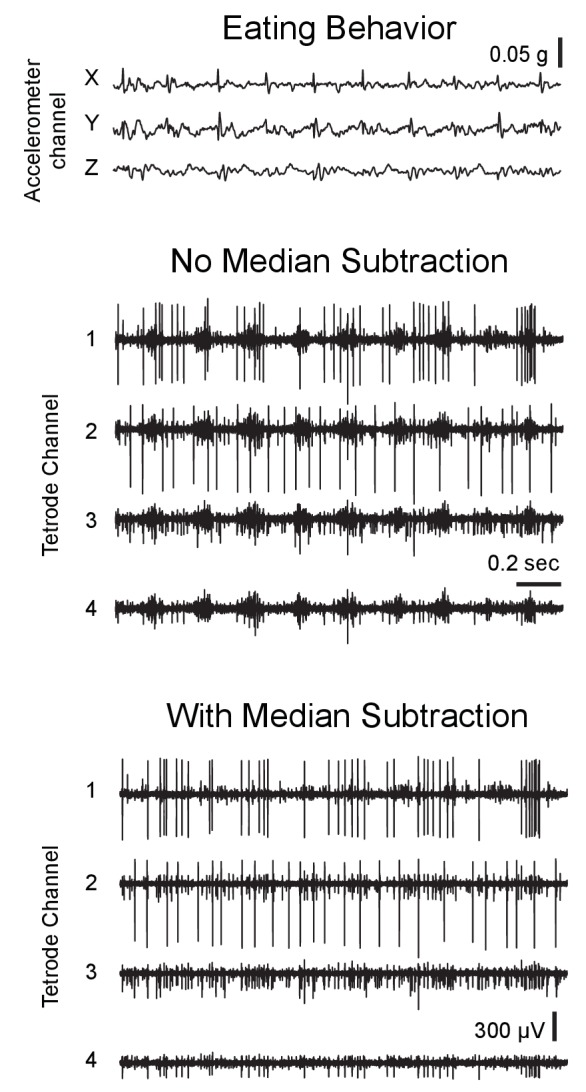
Effect of median subtraction on recording noise in behaving rats.2 s segment of an example 3-axis accelerometer trace (top) and high-pass filtered tetrode recording from the motor cortex (middle) during eating behavior. Note the presence of correlated noise on all 4 electrode channels, presumably arising from activation of muscles responsible for chewing. (Bottom) Subtracting the median activity of all channels (as described in Figure 2—figure supplement 1) from individual electrode channels largely eliminates common-mode noise.